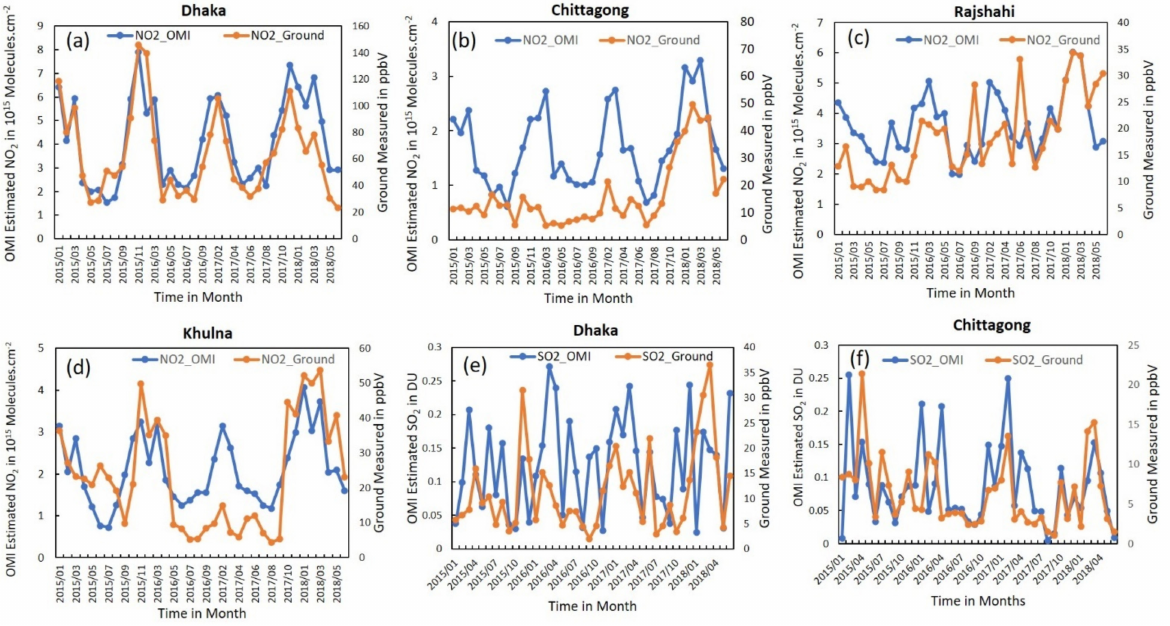
Figure 2. Comparison of the OMI measured column densities and the in situ measured mixing ratios: ( a – d ) NO 2 ; ( e , f ) SO 2